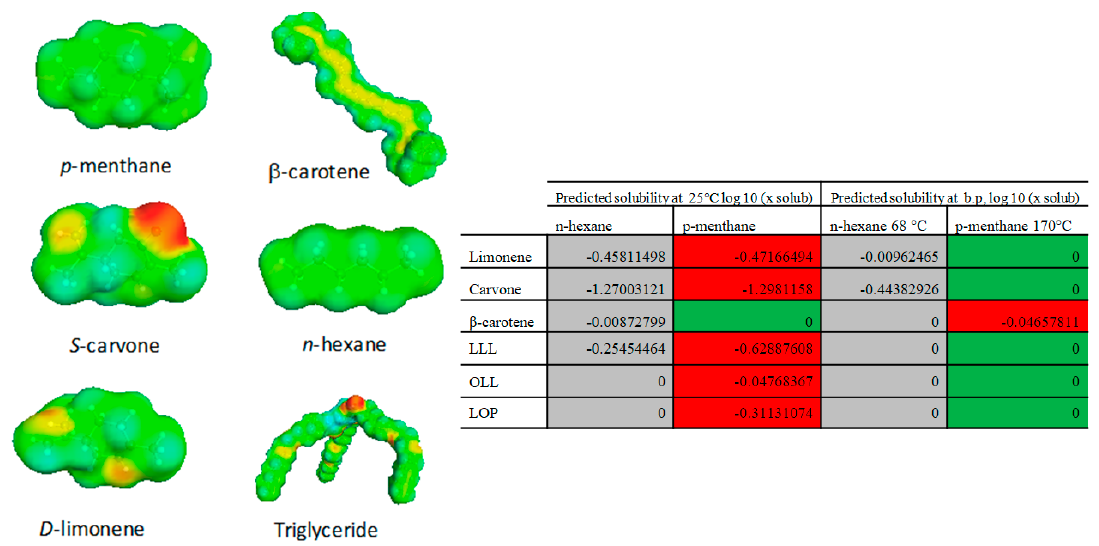
Figure 2. COSMO-RS results of solubility prediction of triglycerides, β -carotene, limonene, and carvone in n -hexane 25 ° C, n -hexane 68 ° C, p -menthane 25 ° C, and p -menthane 170 ° C. Grey (reference), green (better solvent than reference), red (bad solvent than reference). “x-soluble”: solute/solvent ratio expressed as a mole fraction. Gray: reference. Green: better or equivalent. Red: slightly poorer than the reference. Triglycerides abbreviated use L, O, and P for